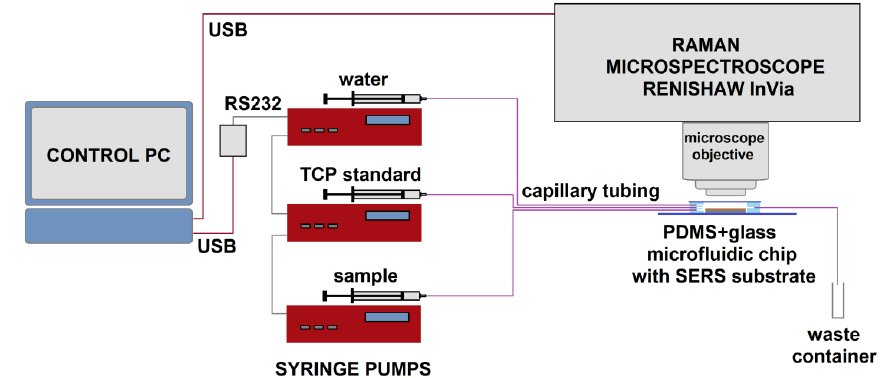
Figure 4. Schematic of the experimental setup for microfluidic SERS based quantitative detection of TCP (1,2,3-trichloropropane) and other chloroalkanes. The microfluidic chip with the SERS